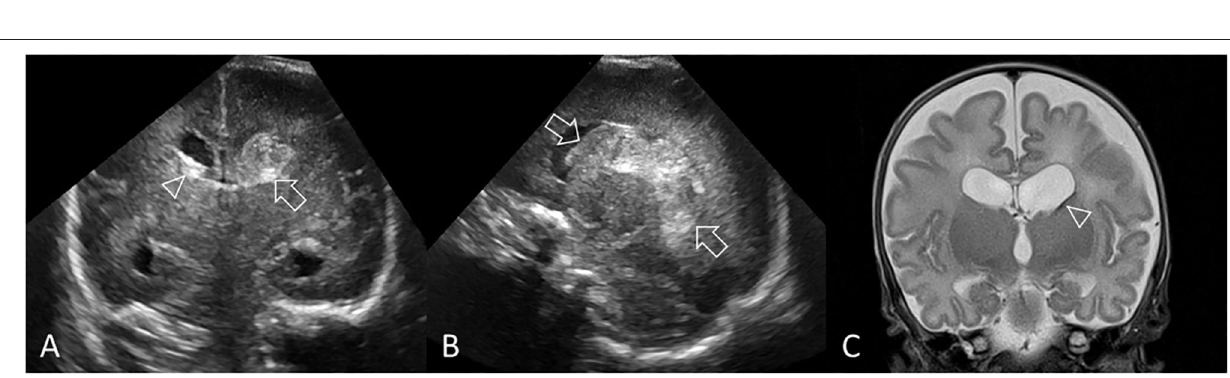
Frontiers in Pediatrics |